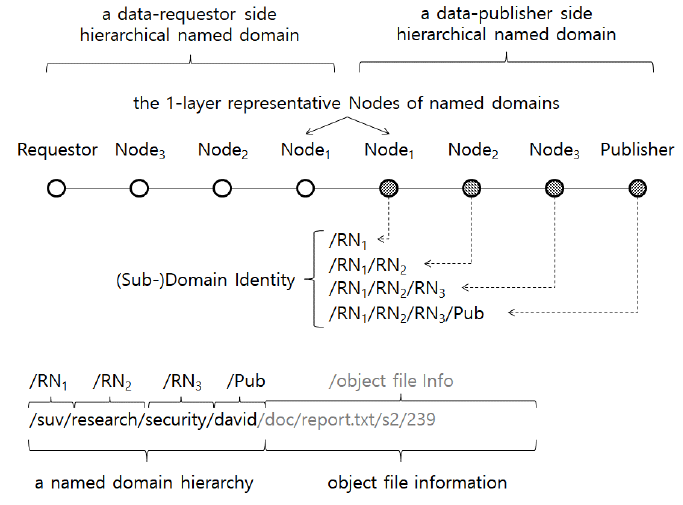
Figure 4. Data name hierarchy.